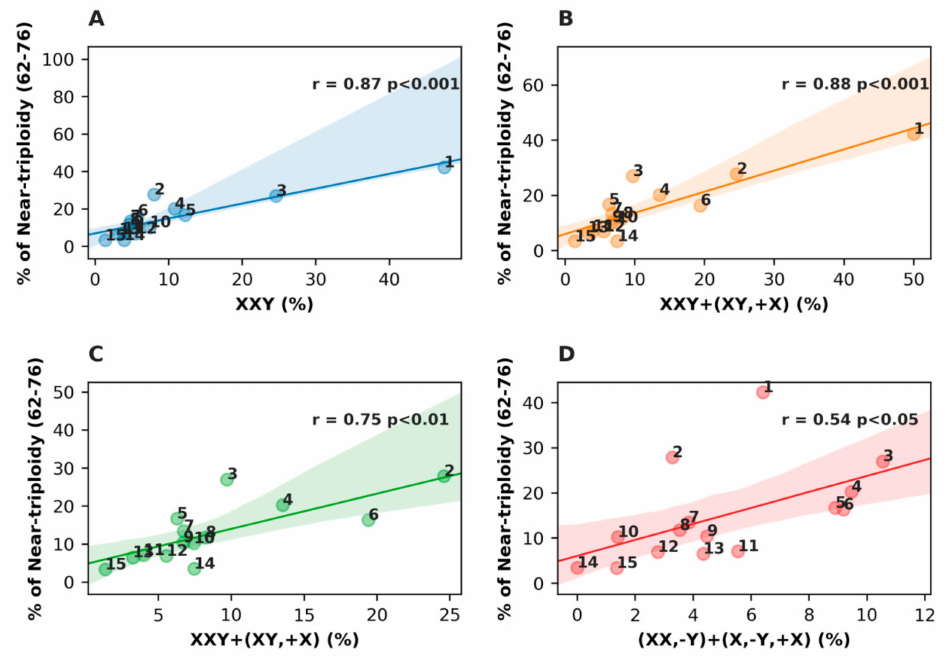
Figure 3. Results of the Pearson correlation analysis for malignant tumors evaluating the relationship between di ff erent karyotypes containing disomic X-chromosomes and ploidy in the median near-triploidy range. ( A ) For XXY and ( B ) XXY + (XY, + X) configurations; ( C ) X-disomic karyotypes with a Y chromosome; and ( D ) X-disomic karyotypes lacking a Y chromosome. The tumor cohort numbers are the same as in Table